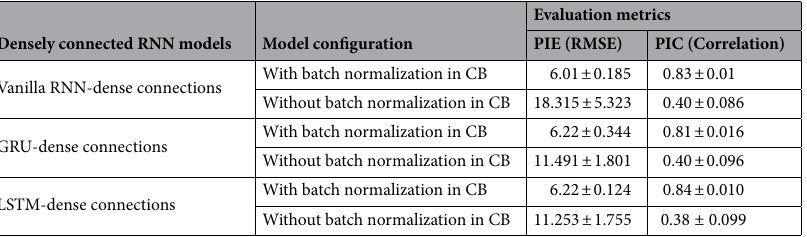
Table 5. Performance comparison between densely connected RNN models with and without batch